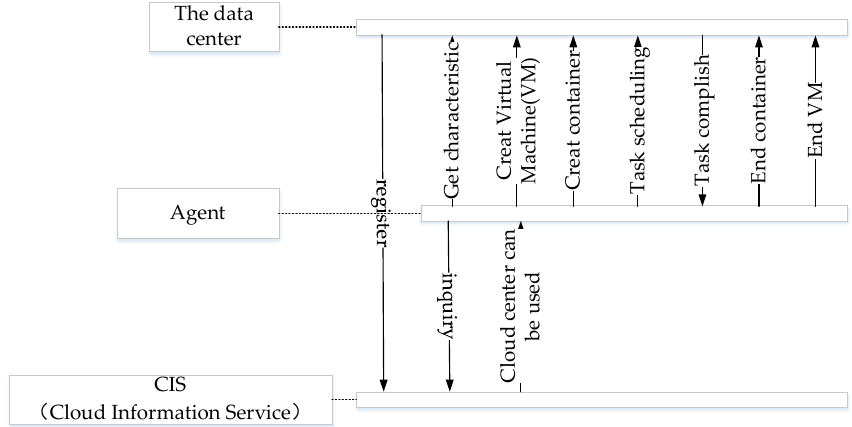
Figure 6. The steps of microservice resource scheduling based on the MFGA.